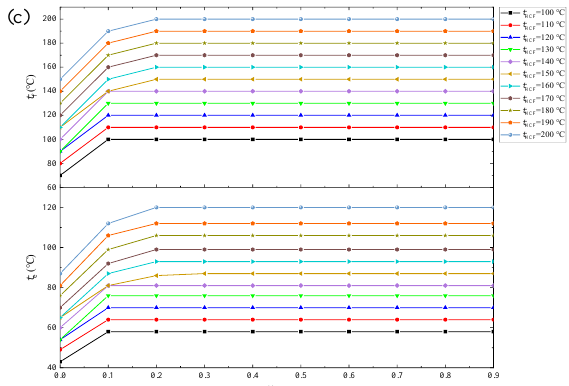
Figure 14. Optimal flash/evaporation temperature corresponding to the optimal W net under different steam quality and temperatures of heat-carrying fluid: ( a ) SF system, ( b ) ORC system and ( c ) SFORC system.